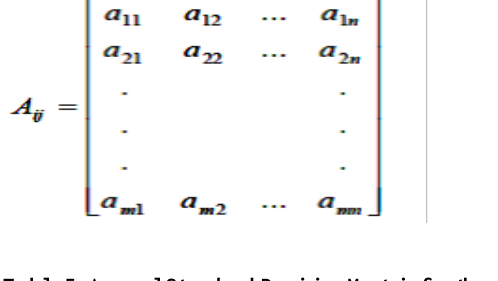
Table 5: Annual Standard Decision Matrix for the